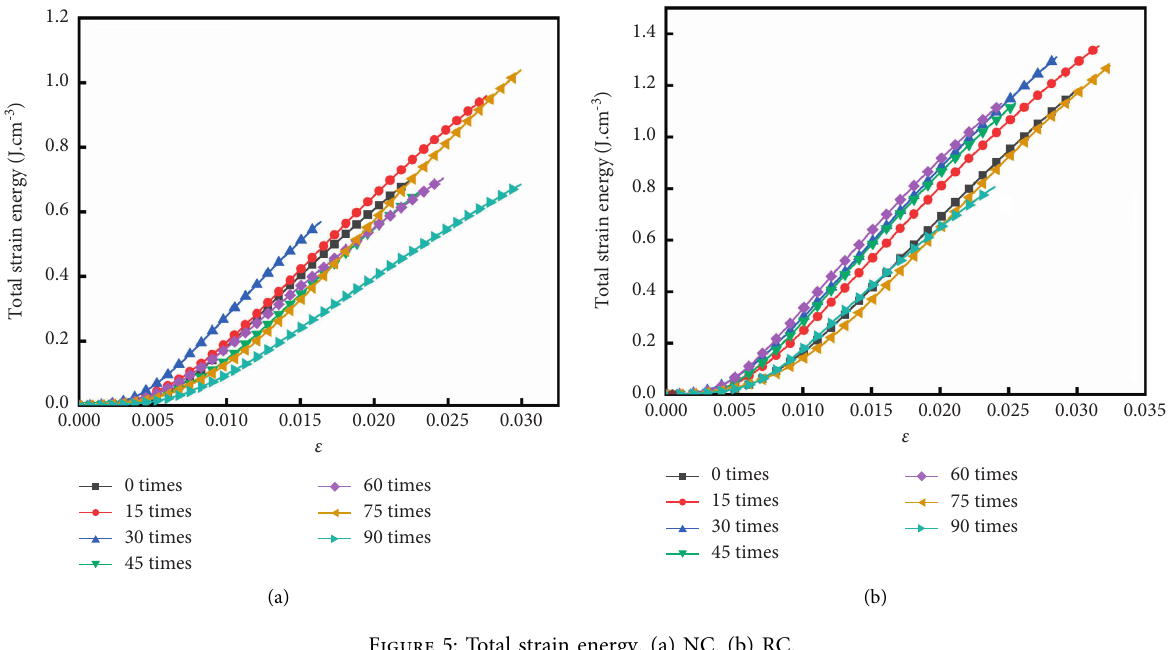
Figure 5: Total strain energy. (a) NC. (b) RC.